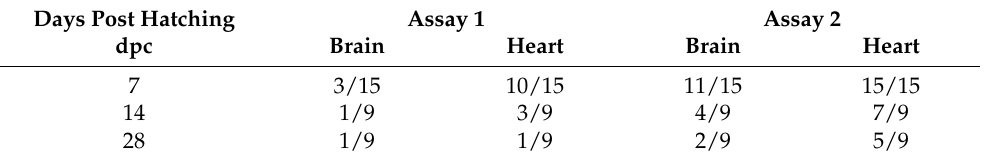
Table 3. Initial comparison of two PCR assays results on brain and heart samples from Atlantic cod Gadus morhua 7–28 dpc with VHSV genotype III. Number of rRT-PCR VHSV-positive